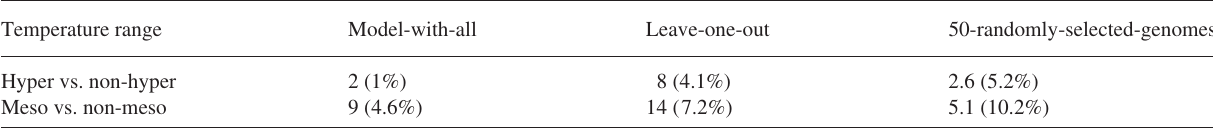
Table 2. Number of misclassifications for two temperature optimum ranges, hyperthermophiles versus non-hyperthermophiles (hyper vs. non-hy- per) and mesophiles versus non-mesophiles (meso vs. non-meso), using all tetramer frequencies over the entire virtual coding strand. Model-with-all is the number of misclassifications when building a model using all 195 genomes. Leave-one-out is the number of mispredictions when classifying an organism against a model built using the other 194 genomes. 50-randomly-selected-genomes is the average number (over 40 iterations) of misclassifications when building a model on 145 genomes and attempting to classify the other 50 randomly selected genomes.